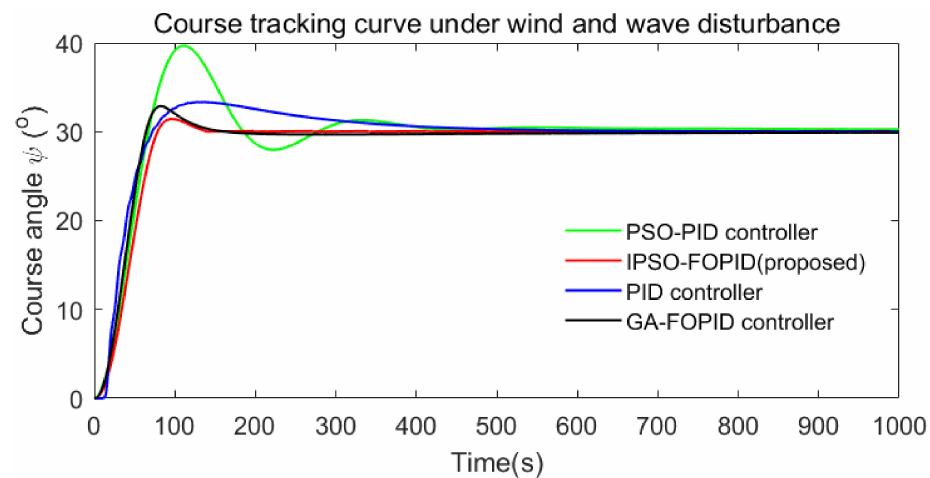
Figure 17. Course-keeping curves under wind and wave disturbances.